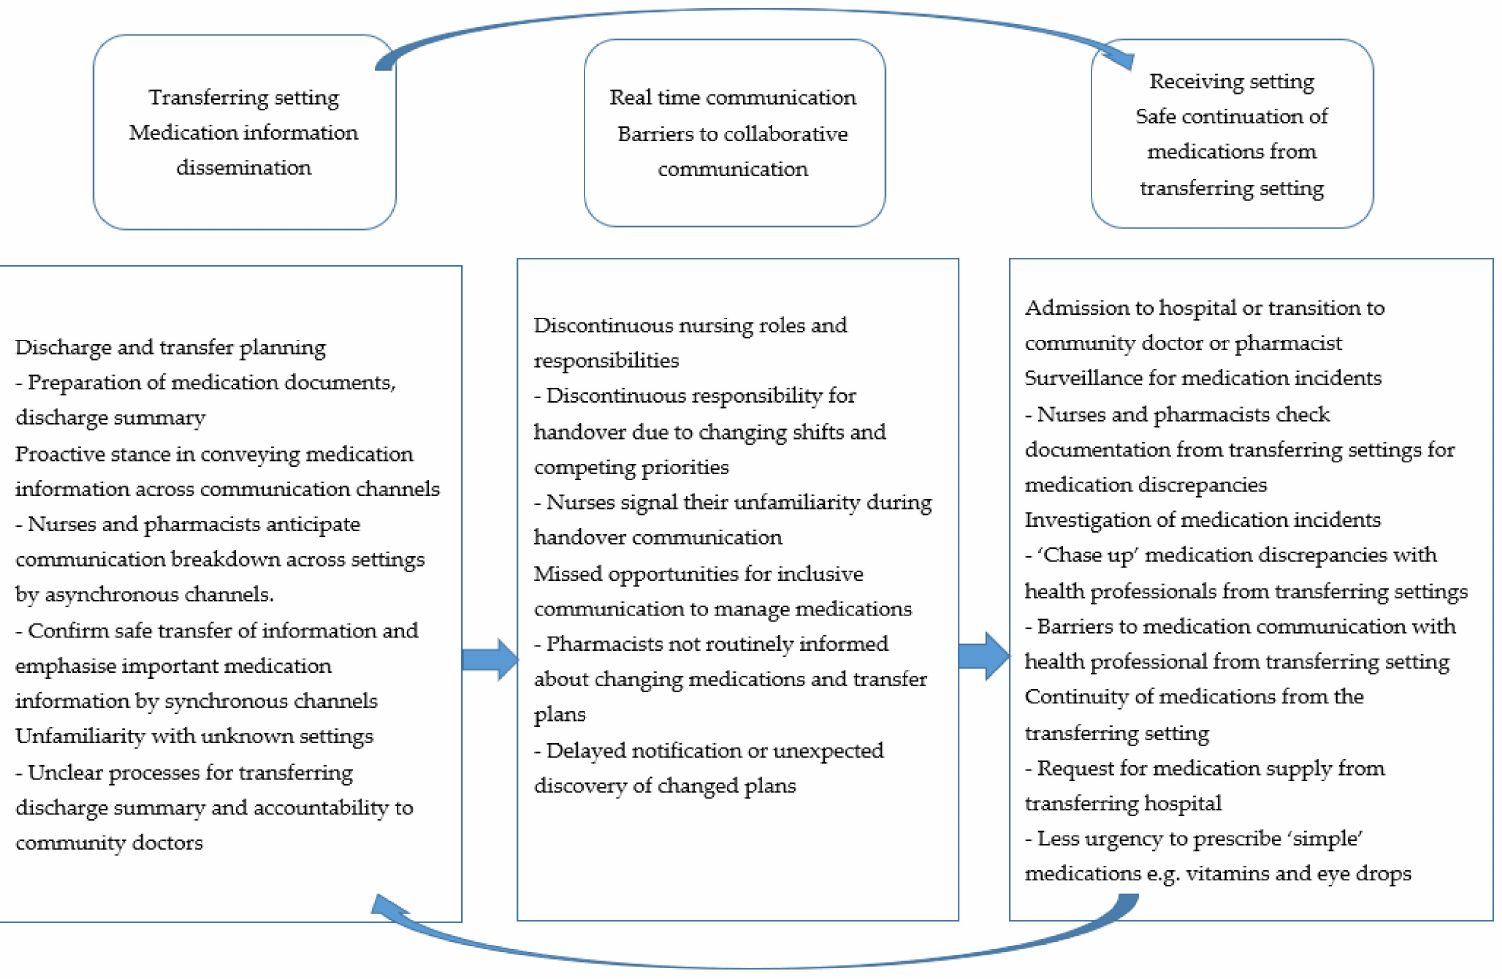
Figure 1. Interprofessional and intraprofessional medication communication between the transferring setting, receiving setting and real time